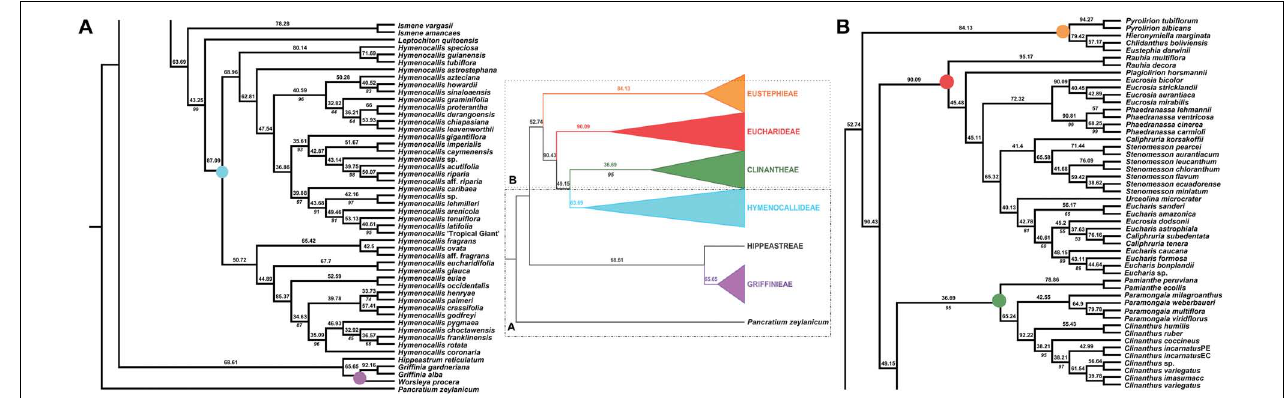
FIGURE 3 | Local posterior probability (LPP) coalescent species tree from ASTRAL III analysis of gene trees of 526 nuclear genes. LPP scores appear above the branches; bootstrap percentages < 100 shown below branches (all unmarked branches have 100% BP). The tree is divided into two sections (A,B) for readability; refer to the colored inset (a cartoon of the tree collapsed to the tribal level) as a guide. Colored circles at the nodes in the full tree conform to clade colors in the inset.